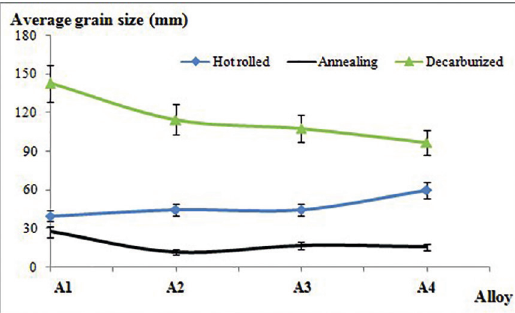
Figure 2 : Grain size evolution during steels fabrication.